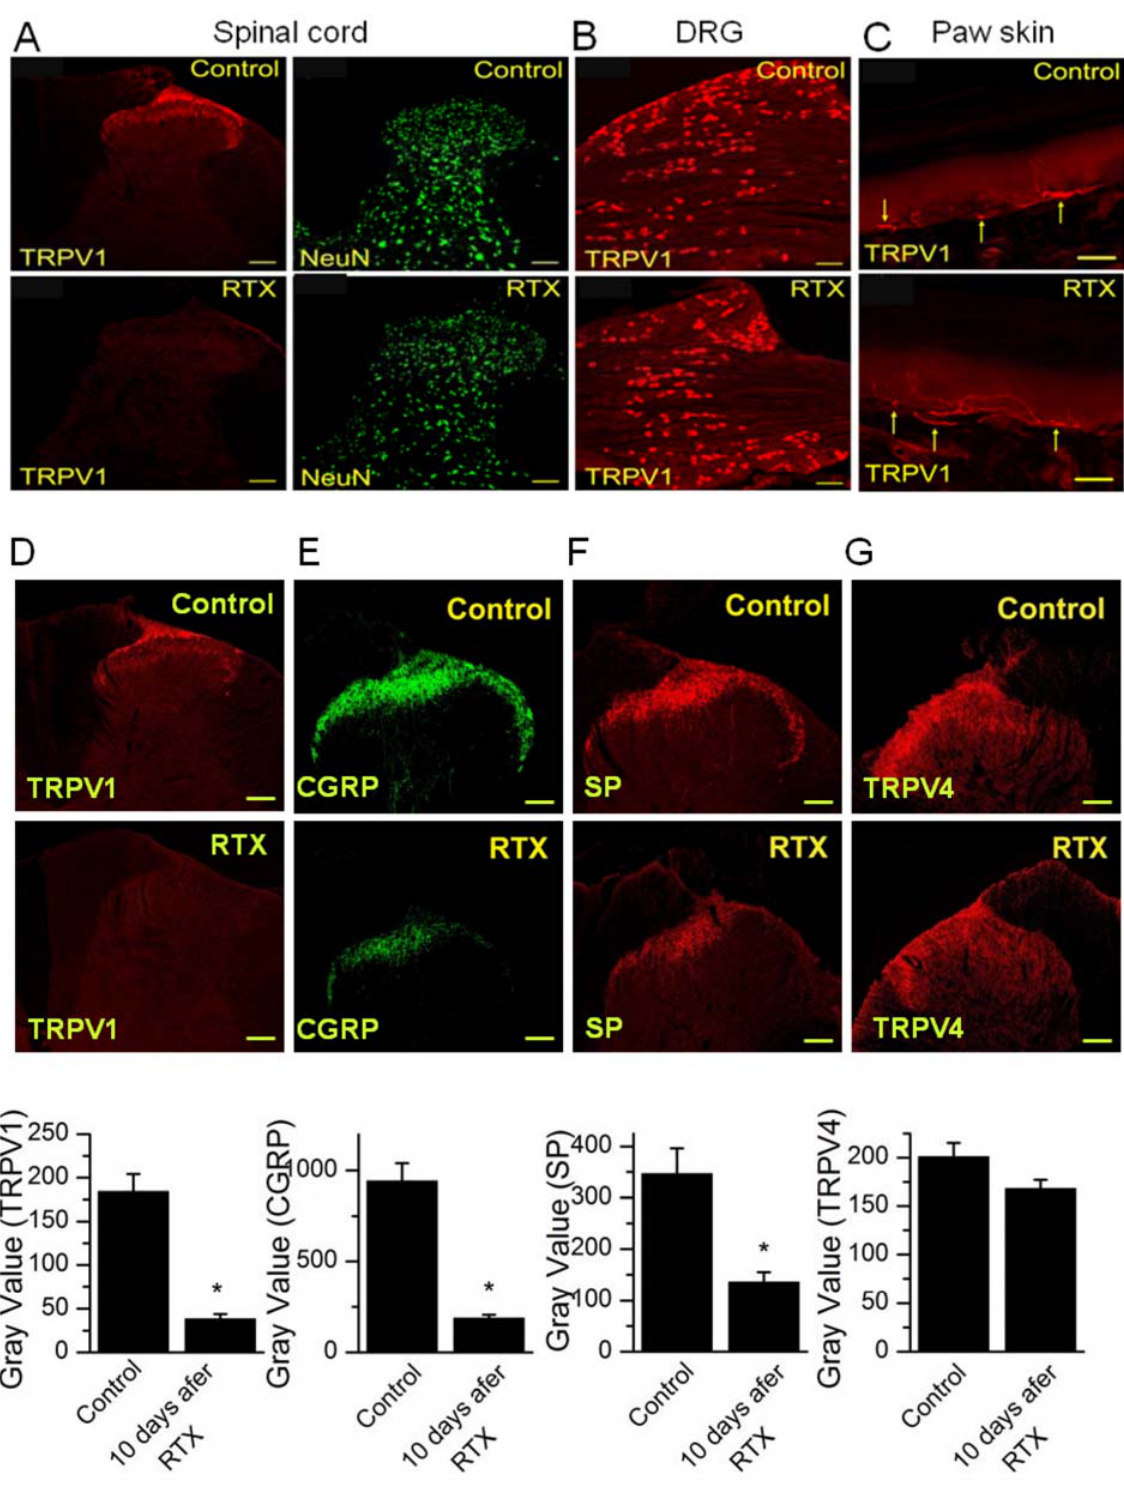
Figure 6. Selective ablation of TRPV1 expressing nerve terminals in spinal cord by intrathecal administration of RTX. Immunofluroscent pictures from control animals (top panel) and animals treated with RTX (1.9 m g/kg) for 20 days (bottom panel). Representative pictures shown are from 3–5 sections stained at least from 3 rats for each group. A. Left panel shows complete loss of TRPV1 staining in spinal dorsal horn after RTX treatment. Right panel shows that there was no change in staining for NeuN, a neuronal marker. B. RTX treatment did not affect the staining or the number of DRG neurons stained. Immunofluroscent pictures of L4 DRG in control animals (top panel) and animals treated with RTX (bottom panel) show no difference in TRPV1 labeling between these two groups. C. TRPV1 staining of paw skin sections did not show a change between controls and following RTX treatment. Sections from another rat show intrathecal RTX eliminated TRPV1 staining ( D ), reduced CGRP staining significantly ( E ) and reduced SP staining significantly ( F ), but did not alter TRPV4 staining in spinal cord ( G ). The corresponding histograms of analysis of gray value of the stained region are shown below. The scale bar is 100 m m except for C it is 50 m m.